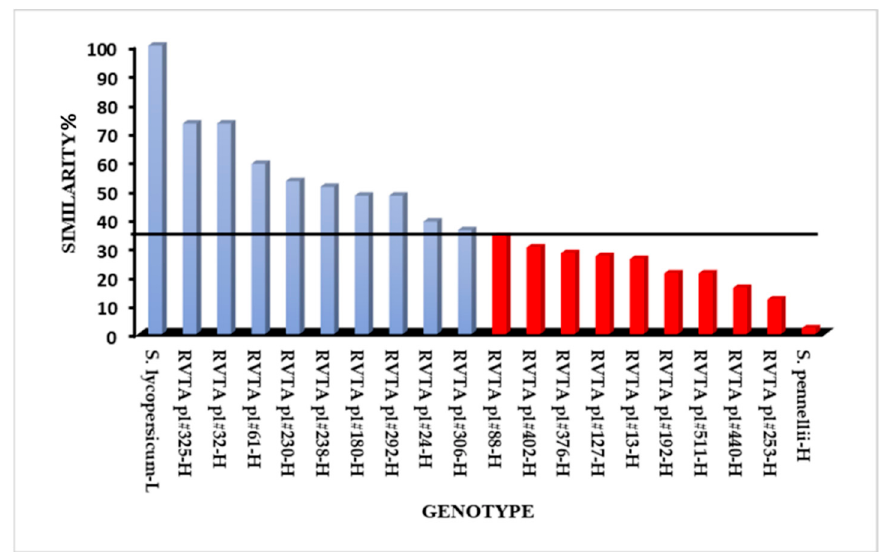
Figure 2. Genetic similarity (%) based on DNA marker analysis of tomato genotypes with high levels of acylsugar, selected from the F 2 BC 3 population, with the recurrent parent S. lycopersicum (‘Redenção’). The horizontal line represents the cutoff point with a similarity index superior to 36%.